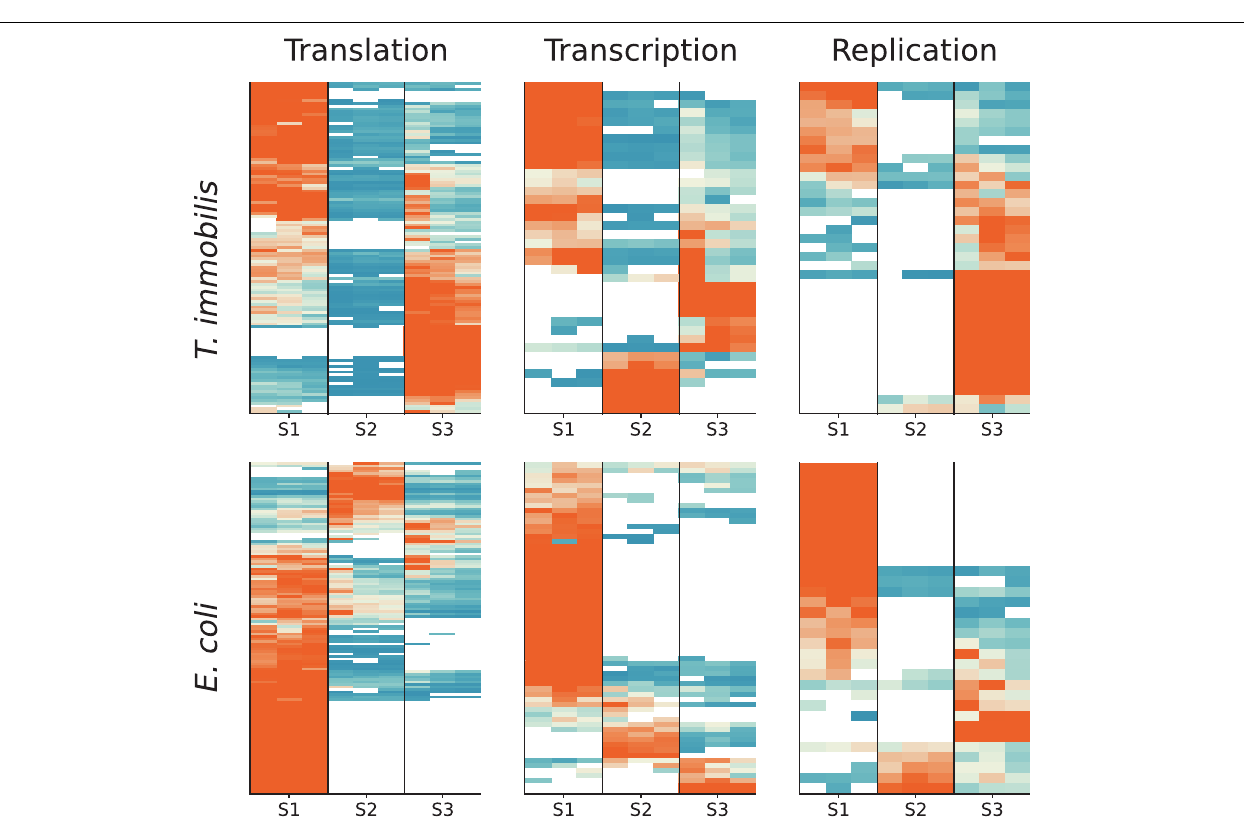
FIGURE 11 | Subcellular fractionation profiles of T. immobilis and E. coli proteins involved in information storage and processing. The relative abundance of proteins (colored according to Figure 4 ) related to COG categories Translation (“J”), Transcription (“K”) and Replication (“L”) are shown for a given subcellular fraction [Tris soluble (S1), Tris/TX-100 soluble (S2), and Tris/SDS soluble